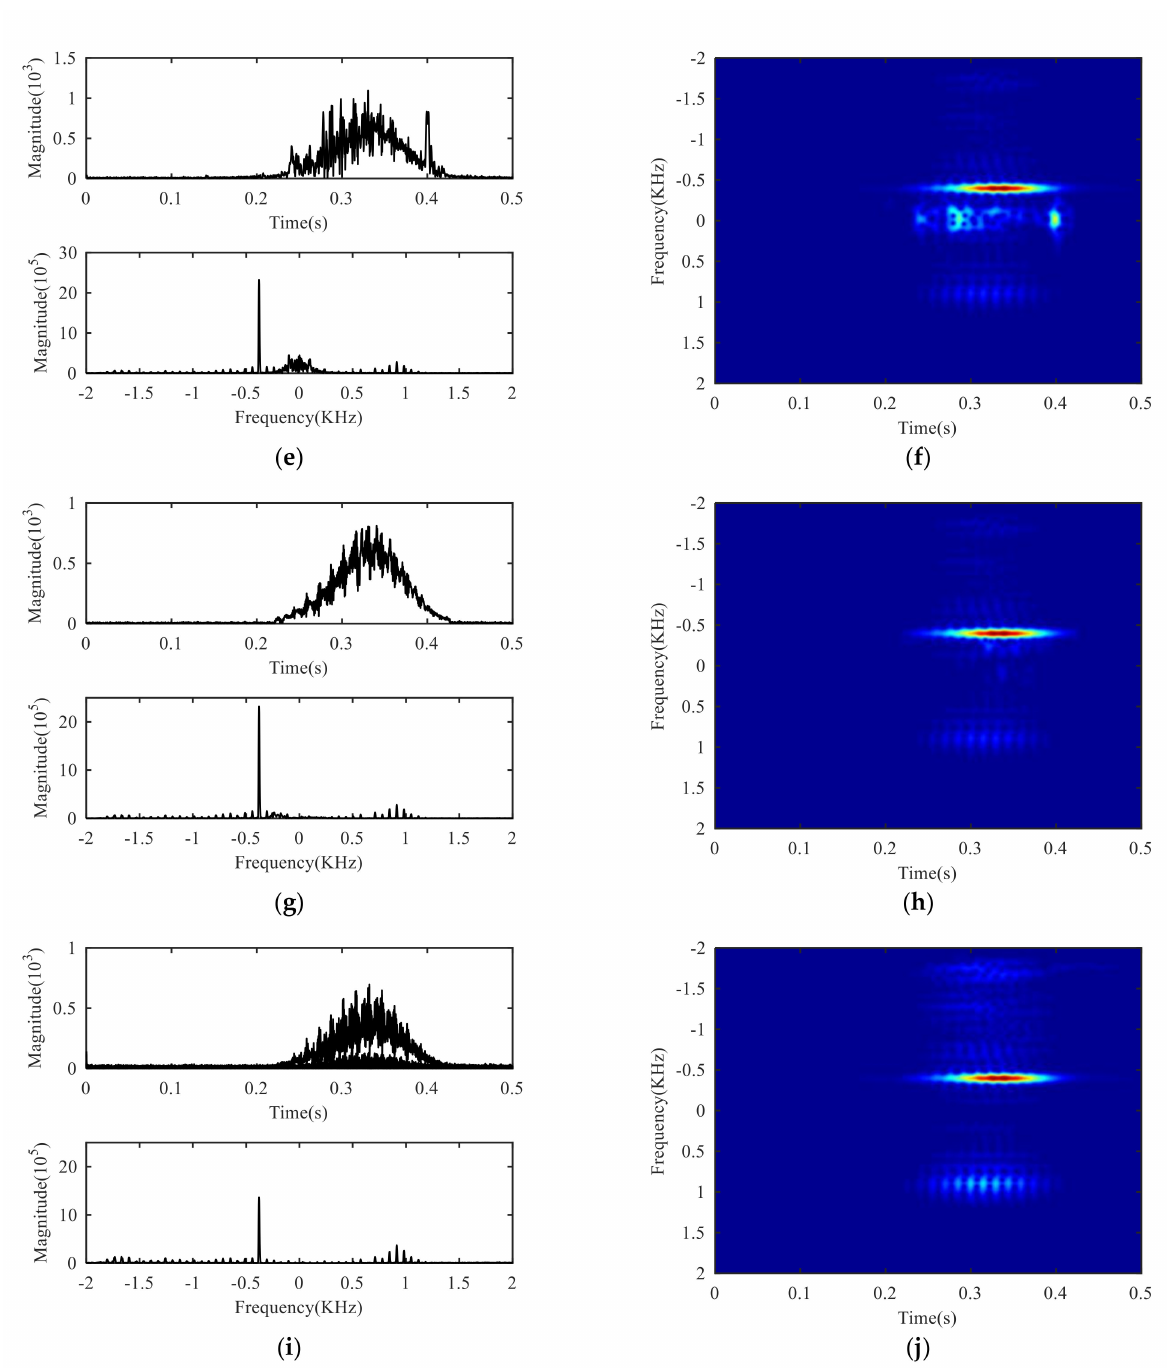
Figure 11. Analysis of propeller data: ( a ) Original signal in time domain and frequency domain, ( b ) original signal in time-frequency domain, ( c ) reconstruction in time domain and frequency domain, ( d ) reconstruction in time-frequency domain, ( e ) reconstruction in time domain and frequency domain by LMD, ( f ) reconstruction in time-frequency domain by LMD, ( g ) reconstruction in time domain and frequency domain by EMD, ( h ) reconstruction in time-frequency domain by EMD, ( i ) result in time domain and frequency domain by MTI, ( j ) result in time-frequency domain by